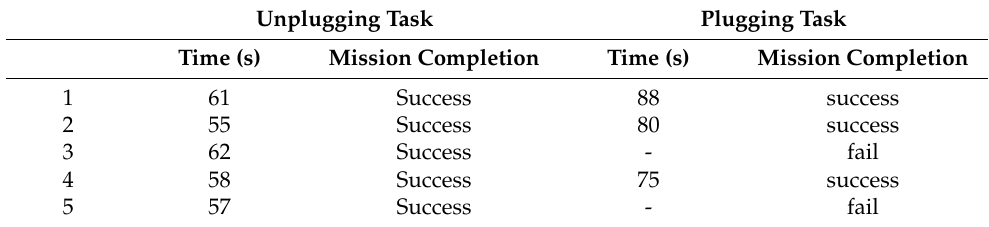
Table 5. Plugging/unplugging experimental results for each